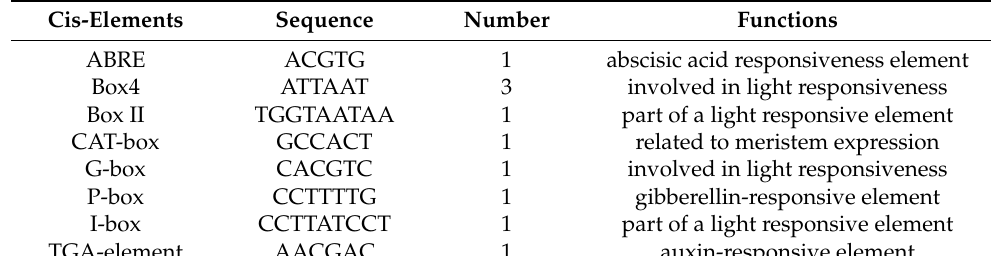
Table 1. Cis-elements analysis of SmSPL6 promoter.